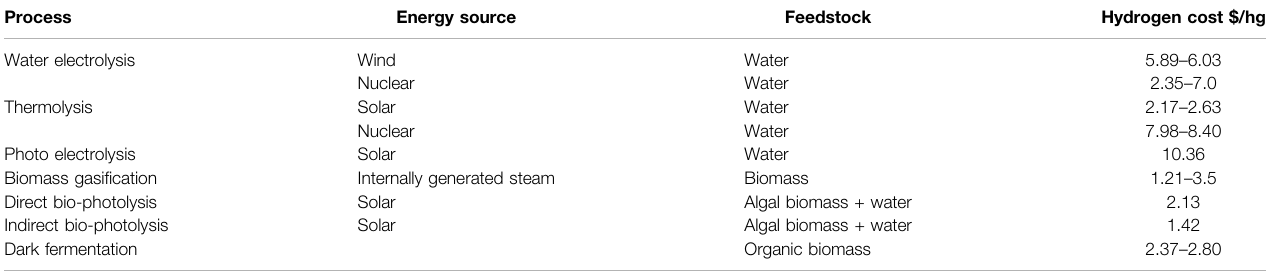
TABLE 3 | Hydrogen cost as a function of different processes (Kayfeci et al., 2019; Nikolaidis and Poullikkas, 2017; Kayfeci et al., 2019 and Lepage et al., 2021).